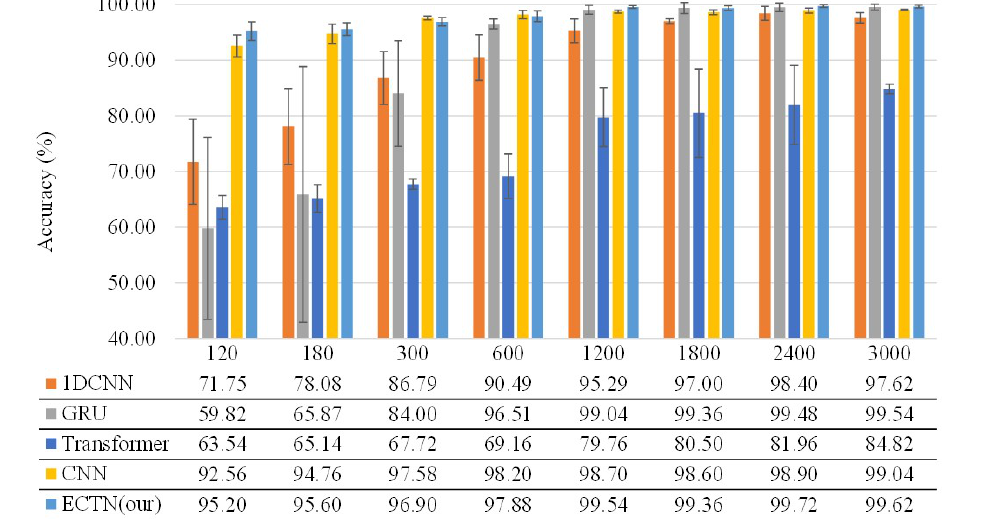
Figure 6. Diagnosis results of the proposed method compared with those of the comparison model for different training sample